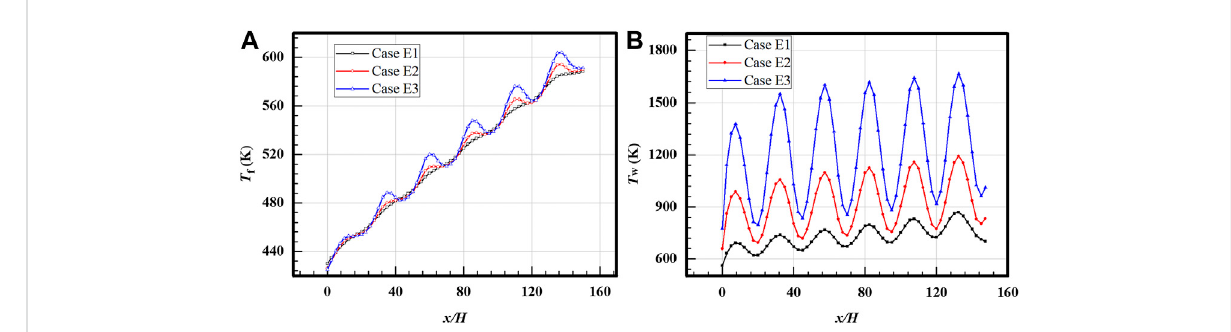
FIGURE 13 Temperature distributions of cases with different thermal conductivities, respectively, Al, steel, and Ti. (A) Fluid temperature. (B) Wall